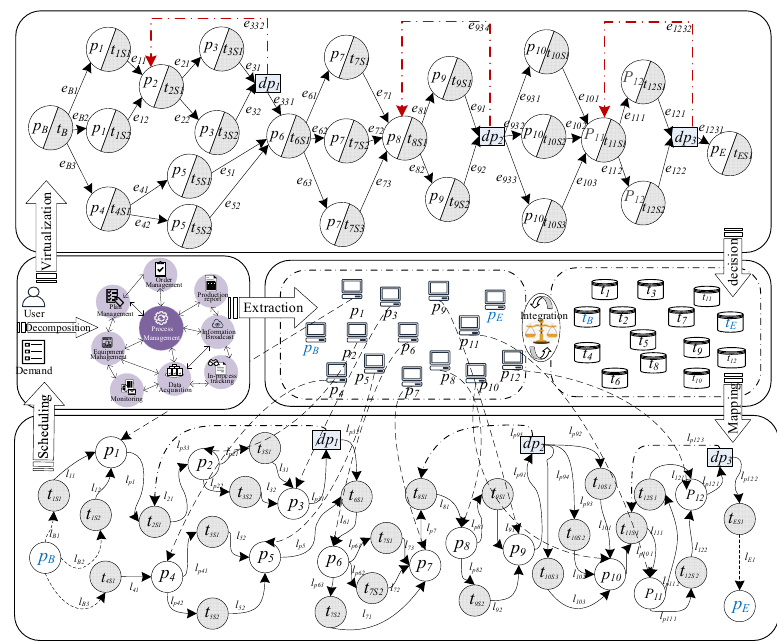
Figure 1. Non-linear production process work- fl ow model schematic.